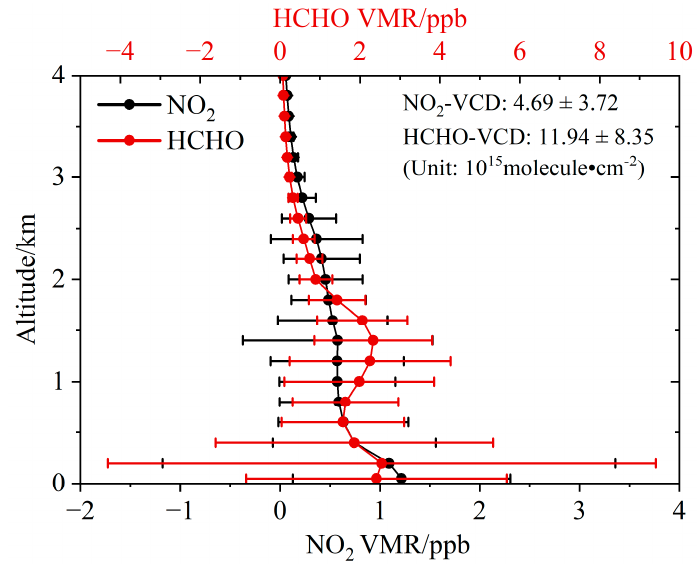
Figure 3. Vertical profiles of NO 2 (black) and HCHO (red) VMRs. The lines with dots and the error bars indicate the means and standard deviations at different altitudes during the observation period. The averaged values ± standard deviations of tropospheric NO 2 and HCHO VCDs (Unit: 10 15 molecule · cm − 2 ) during the observation period are also shown in the figure.